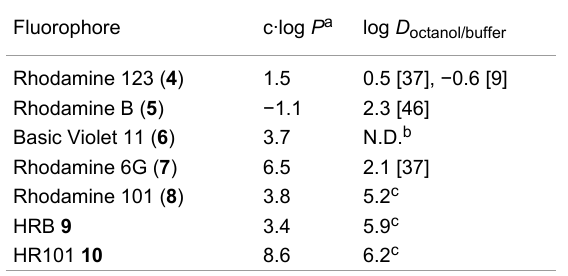
Table 1: Partition constants of fluorophores.